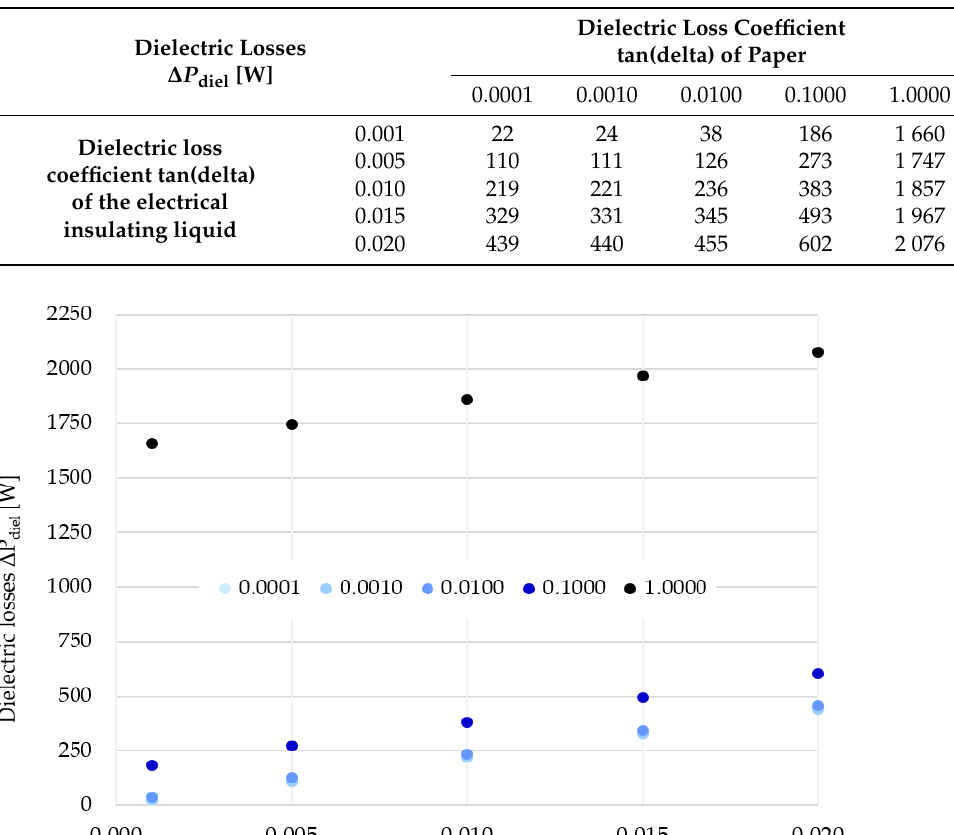
Figure 4. Dielectric losses in the selected transformer depending on the dielectric loss coefficient tan(delta) of the paper and the electrical insulating liquid (legend corresponds to the dielectric loss coefficient tan(delta) of the paper).